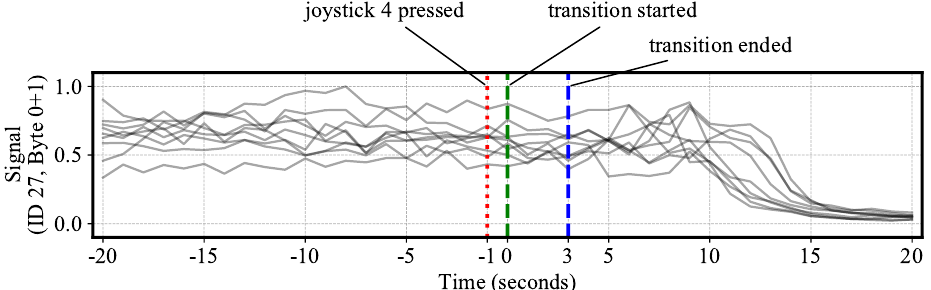
Figure 19. Extracted signal traces from CAN ID 27 are visualized with both selected header position and operation action labels. By incorporating context, the meaning of the signal traces can be interpreted as flow or yield sensor